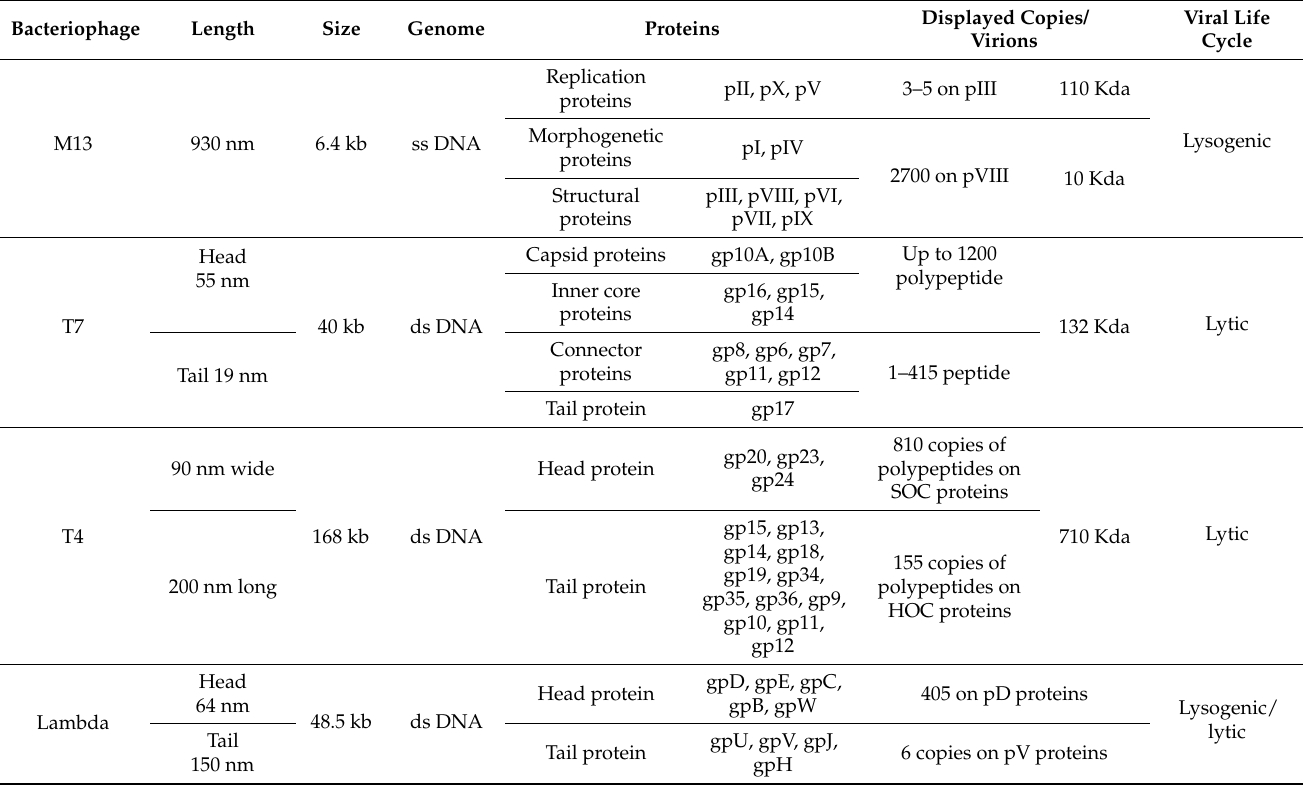
Table 1. Specific characteristics of the main bacteriophages used in phage